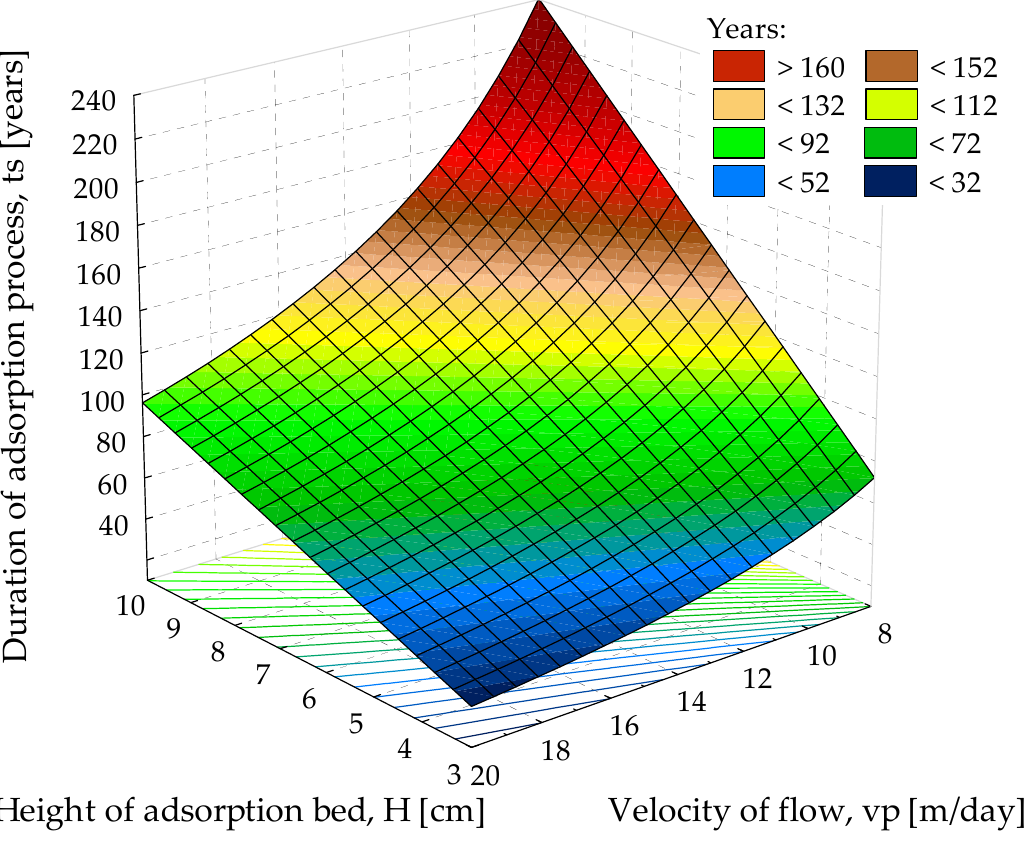
Figure 5. Graph of the working time of the sewage sludge compost bed t s (years) depending on bed height H (m) and flow velocity v P , based on results from the IZO